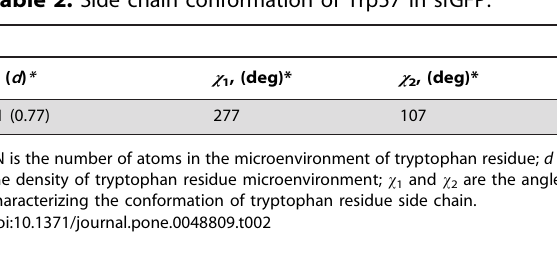
Table 2. Side chain conformation of Trp57 in sfGFP.